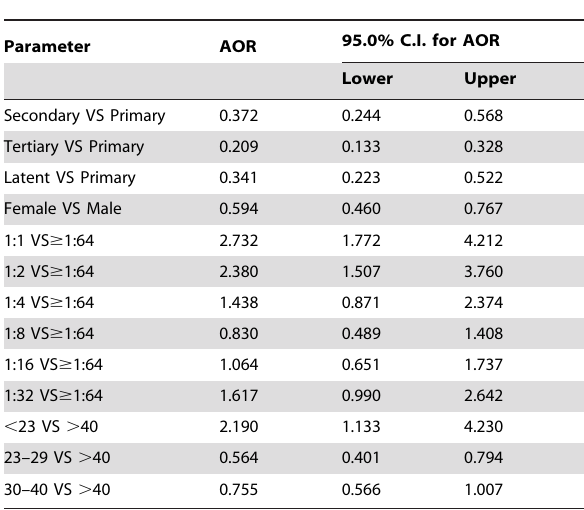
Table 2. Multivariate analysis of the characteristics of patients who achieved serological